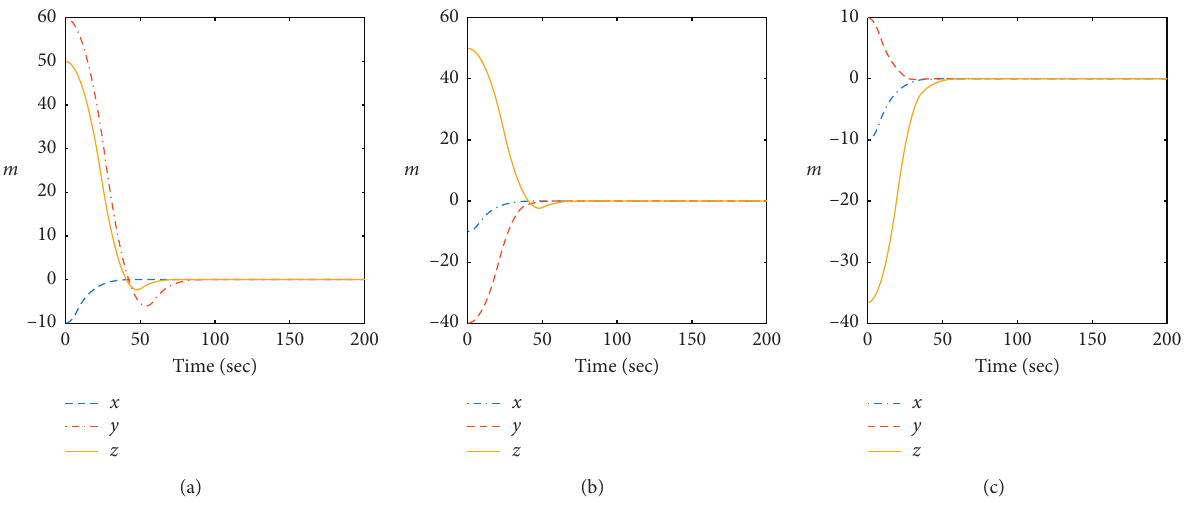
Figure 5: The curves of the relative position error. (a) Sat1. (b) Sat2. (c) Sat3.